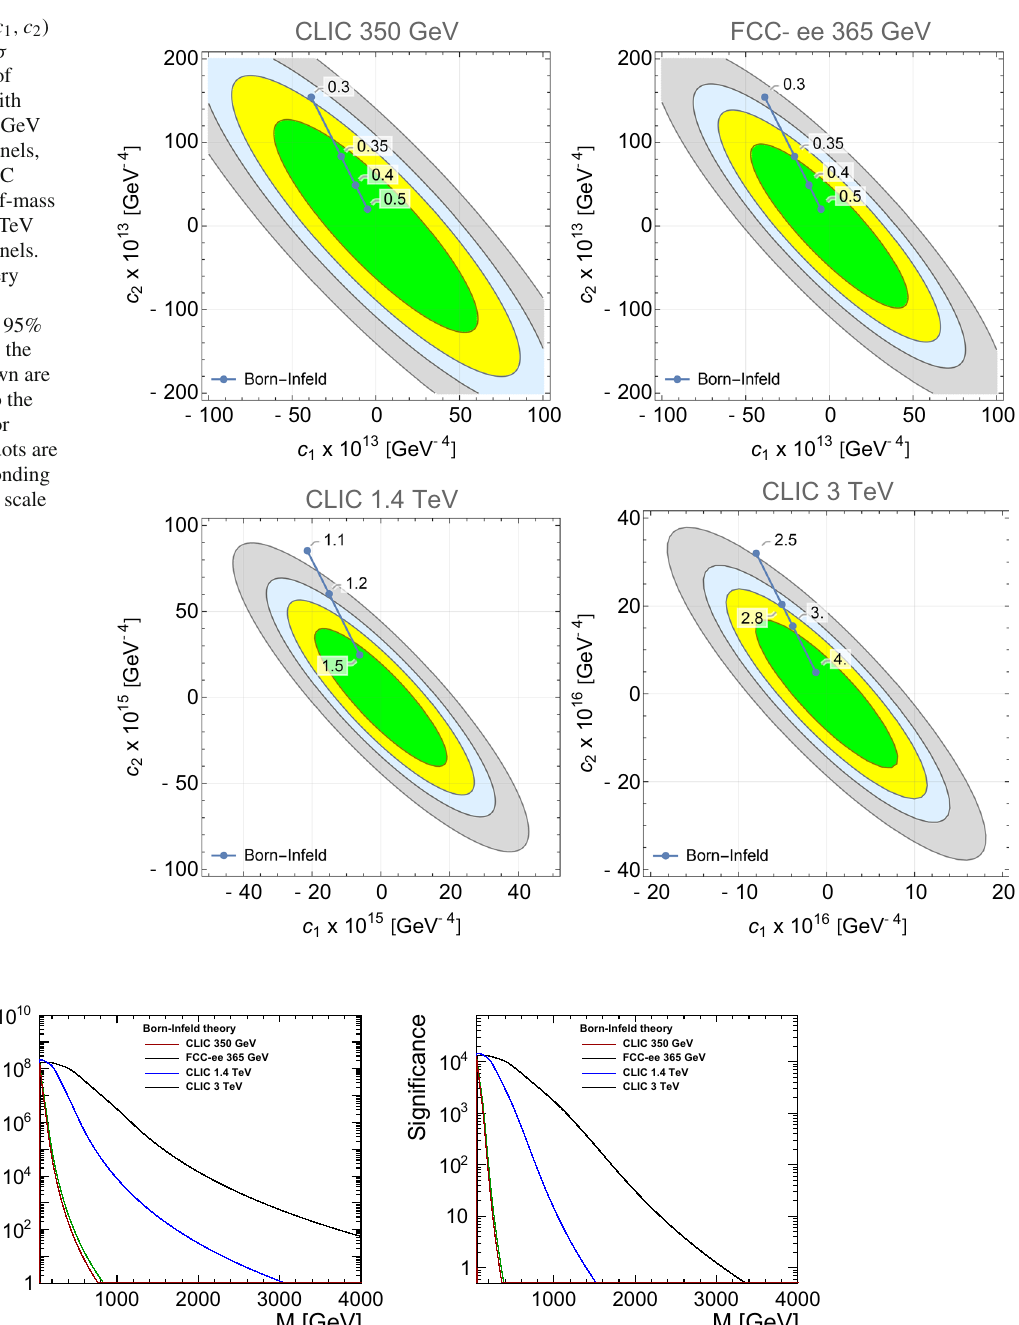
Fig. 7 Left panel: the number of γγ → γγ events in Born–Infeld theory [2] as a function of the Born–Infeld scale M at 350 GeV CLIC, FCC-ee, 1.4 TeV CLIC and 3 TeV CLIC (red, green, blue and black histograms, respectively). Right panel: the statistical significances of